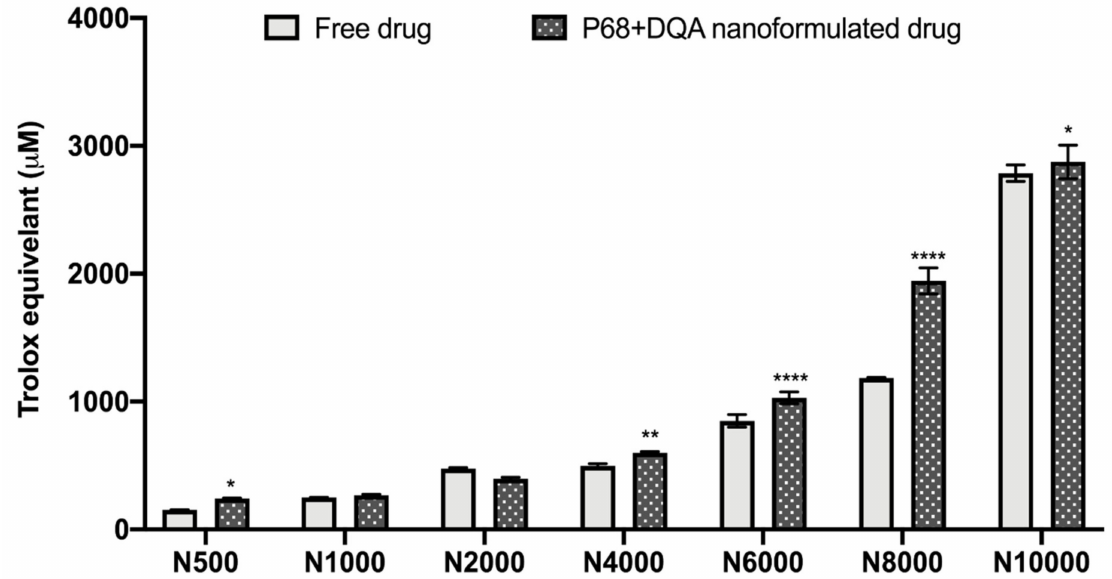
Figure 2. Antioxidant capacity of free and P68 + DQA nanoformulated 500–10,000 µ M NAC measured by the ferric reducing antioxidant power (FRAP) assay (mean ± S.D., n = 6). * represents significance values of nanoformulated drug compared to free drug within the same treatment condition (**** p < 0.0001, ** p < 0.01, * p <